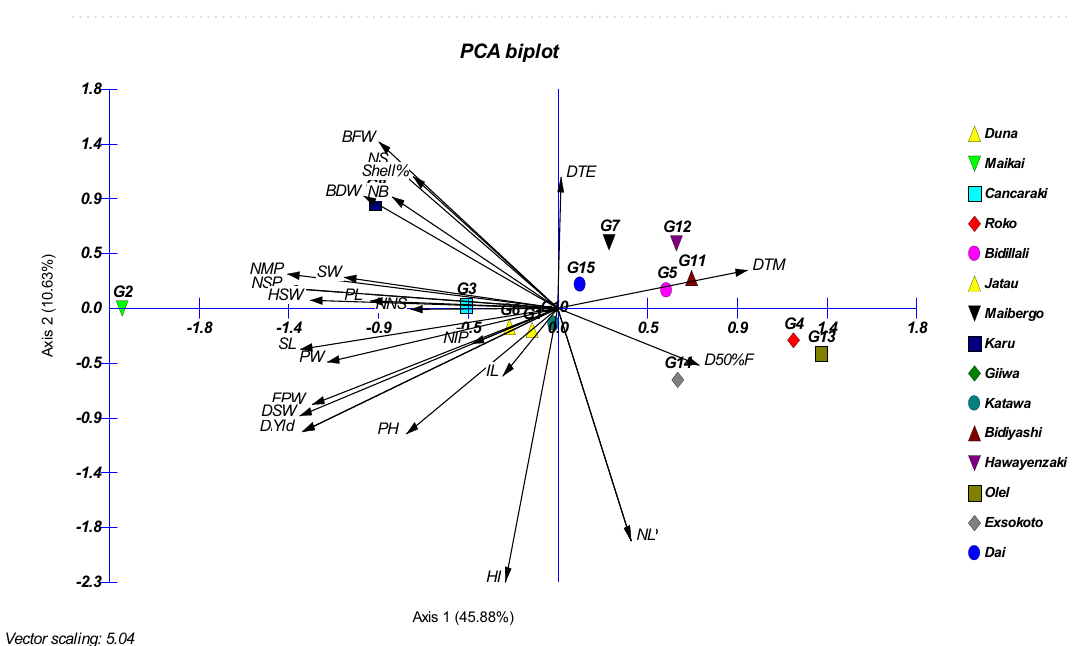
Figure 9. PCA biplot with variables (27) and cases (15) loading of Bambara groundnuts accessions using